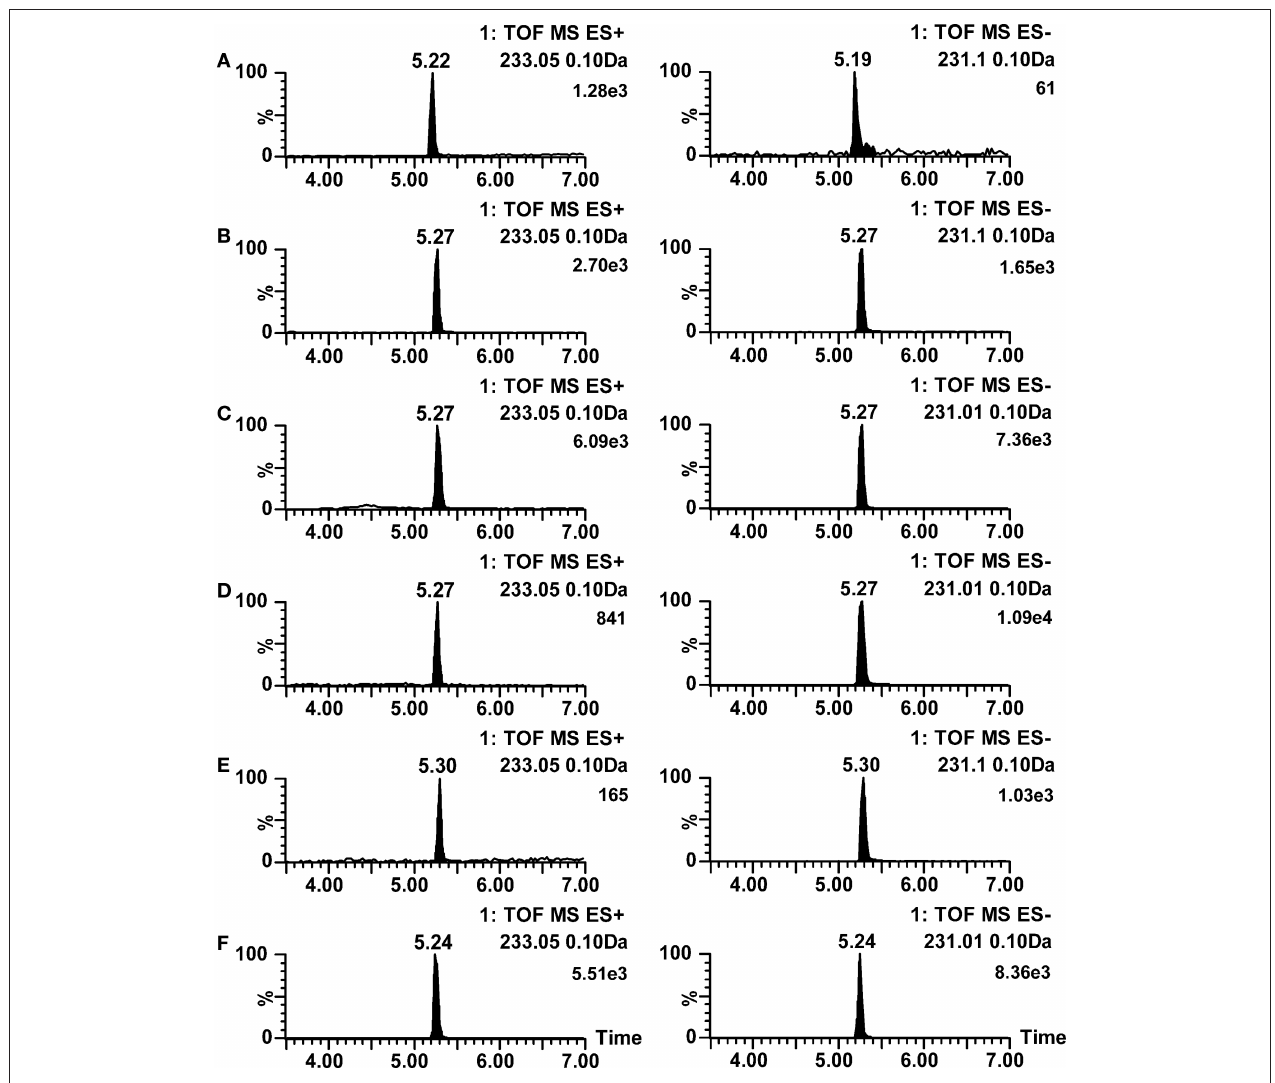
FIgurE 6 | Positive and negative ion mode LC–ESI–TOF–MS ion chromatograms for diuron at various mobile phase pH conditions. (A) 0.1% formic acid (pH 2.8); (B) 0.1% acetic acid (pH 3.2); (C) 2 mM ammonium